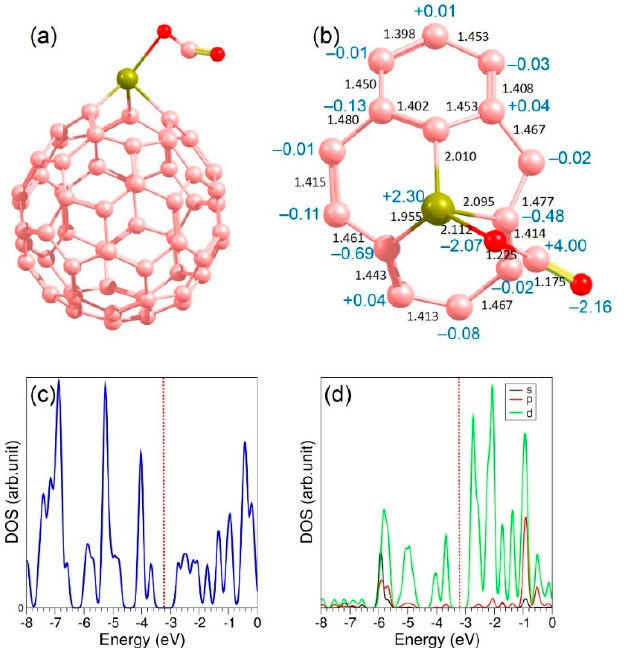
Figure 8. Relaxed structure showing ( a ) a CO 2 molecule adsorbed on the Ti-doped surface, ( b ) bond distances and Bader charges on the atoms, ( c ) total DOS plot and the ( d ) atomic DOS plot of Ti.